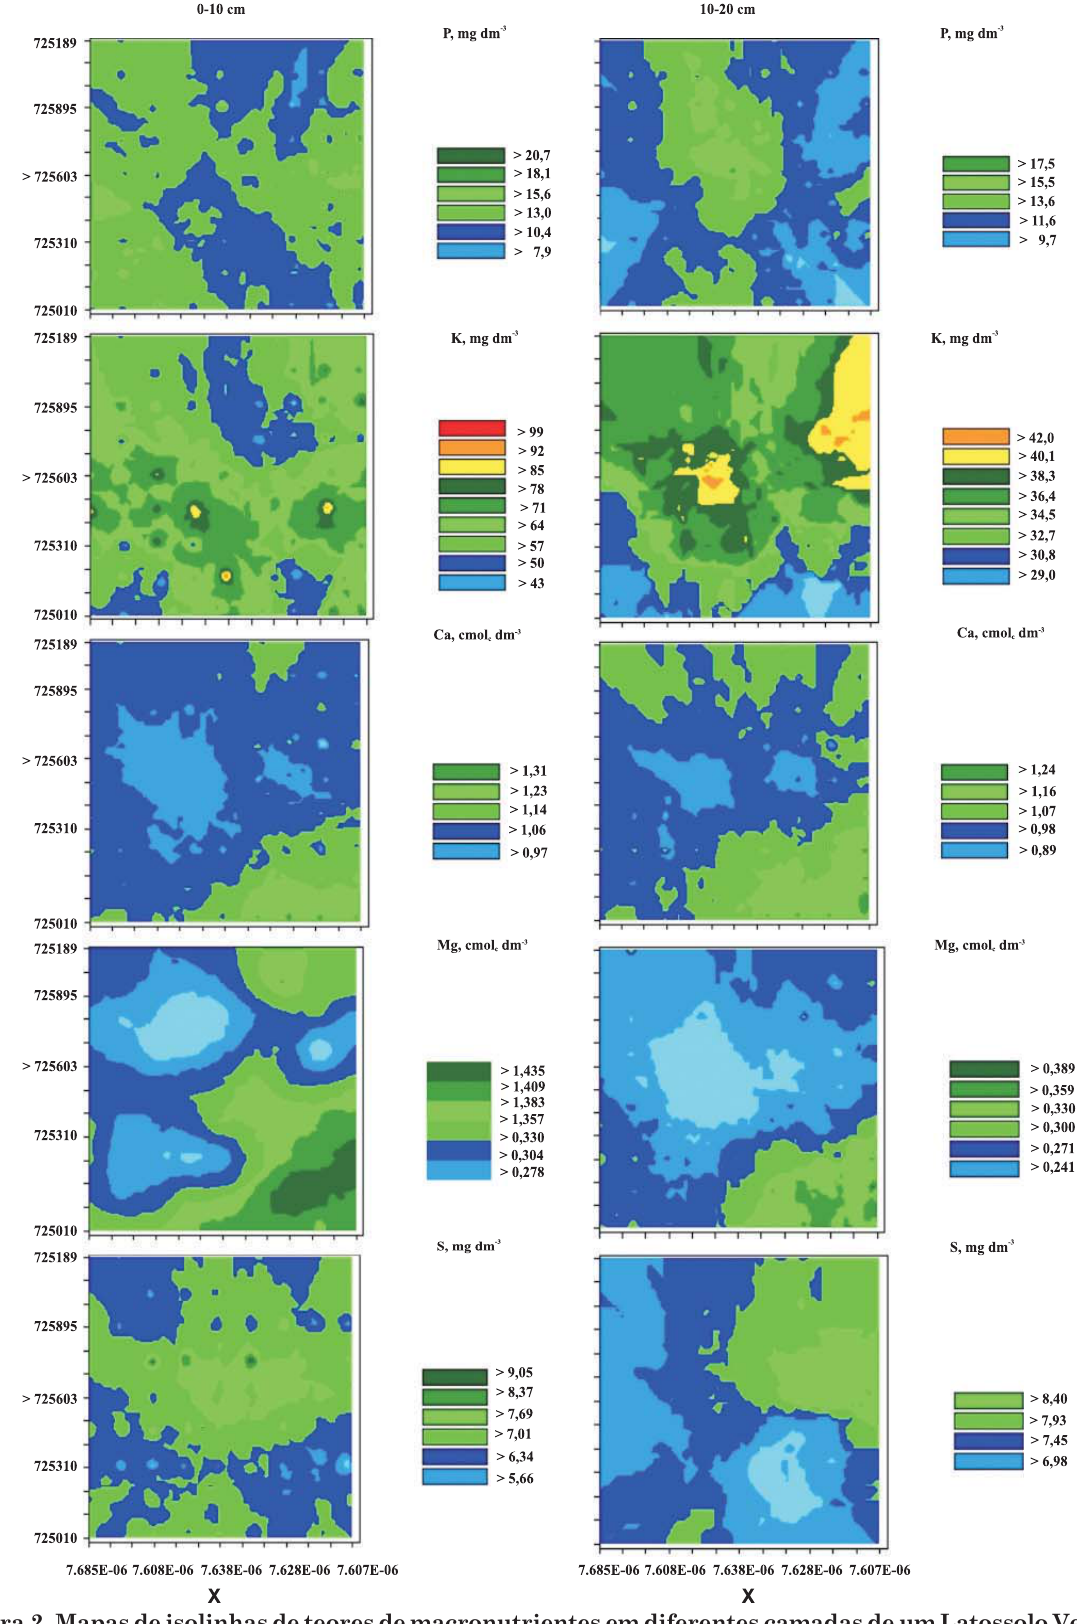
Figura 2. Mapas de isolinhas de teores de macronutrientes em diferentes camadas de um Latossolo Vemelho textura média, sob sistema plantio direto (Fazenda São Luiz de